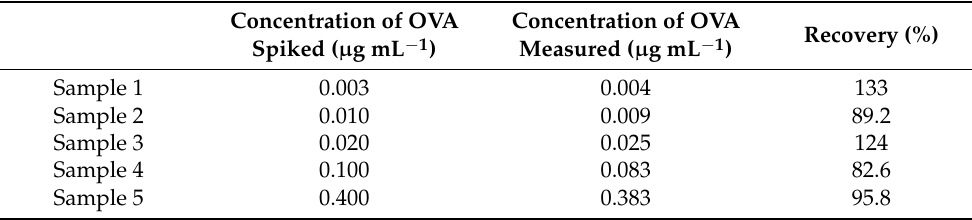
Table 2. Results of the recovery study of the origami µ PAD biosensor performed on a blank extract of biscuit sample spiked with known amounts of OVA.